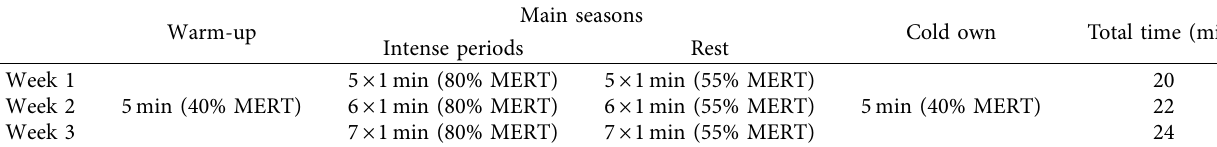
Table 1: High-intensity interval training